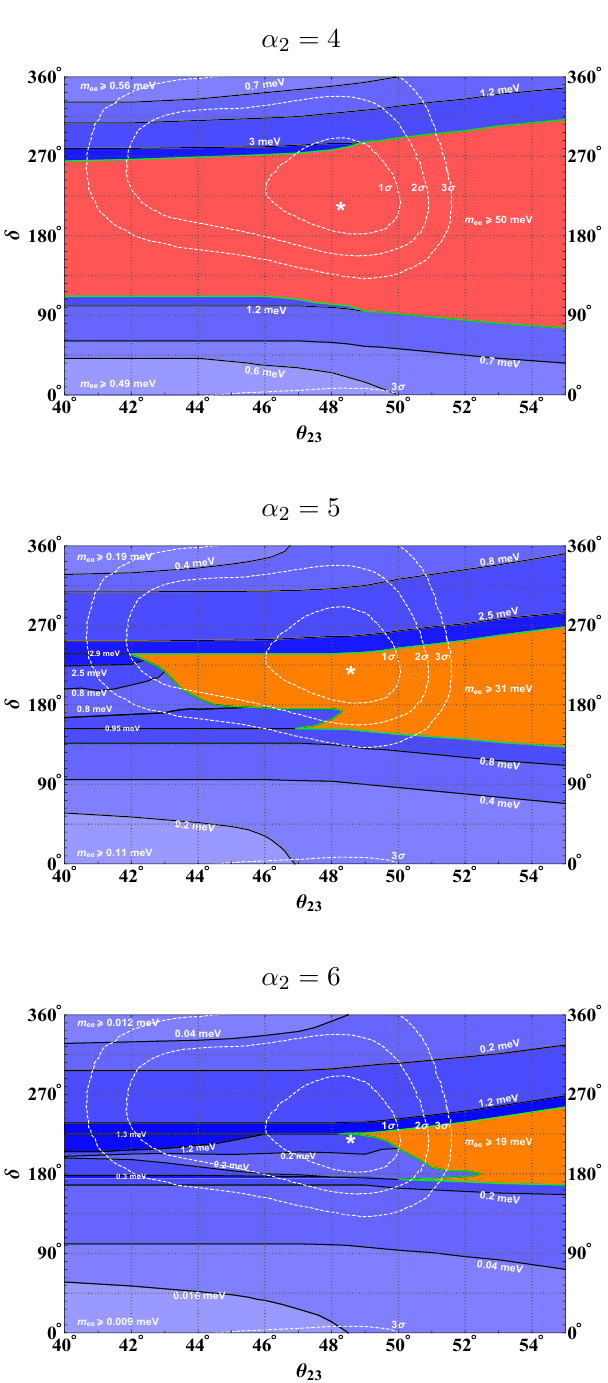
Figure 4 . Isocontour lines for the lower bound on m ee in the plane ( (cid:18) 23 ; (cid:14) ) (same conventions as in (cid:12)gure 2) for the three indicated values of (cid:11) 2